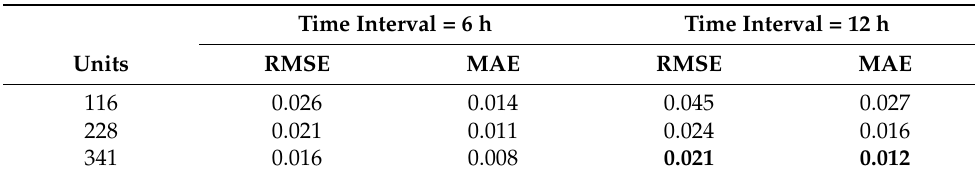
Table 3. Root mean square error (RMSE) and mean absolute error (MAE) at different time interval lengths.